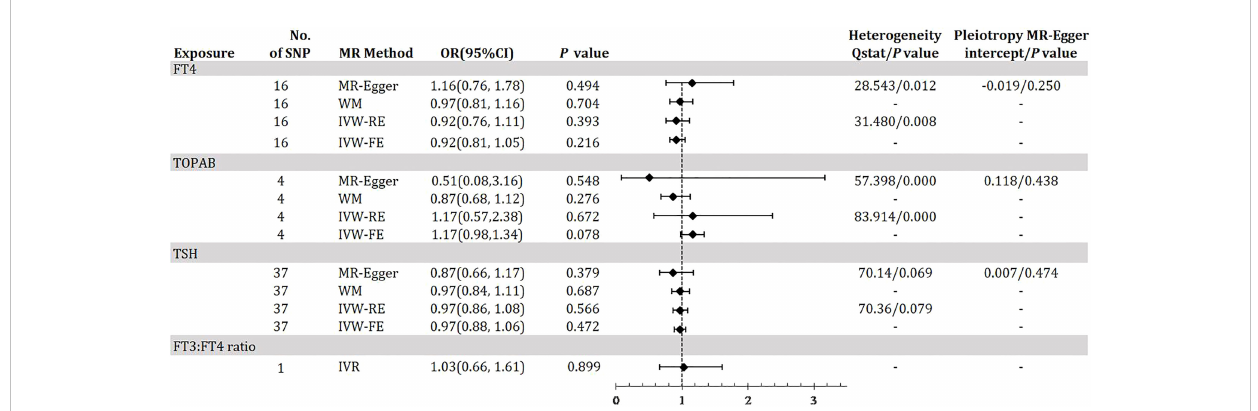
FIGURE 5 Odds ratio for association of genetically predicted thyroid function with PDR. FT4, free thyroxine; FT4, free thyroxine; FT3, free triiodothyronine; TSH, thyroid-stimulating hormone; TPOAB, thyroid peroxidase antibodies; PDR, proliferative diabetic retinopathy; CI, con fi dence internal; OR, odds ratio; IVW-FE, inverse-variance weighted fi xed-effects MR; IVW-RE, inverse-variance weighted random-effects MR; MR, mendelian randomization; WM, weighted median; IVR, instrumental variable ratio (Wald) estimator; SNP, single-nucleotide polymorphism. P value for heterogeneity based on Cochran ’ s Q statistic for IVW, and Rücker ’ s Q for